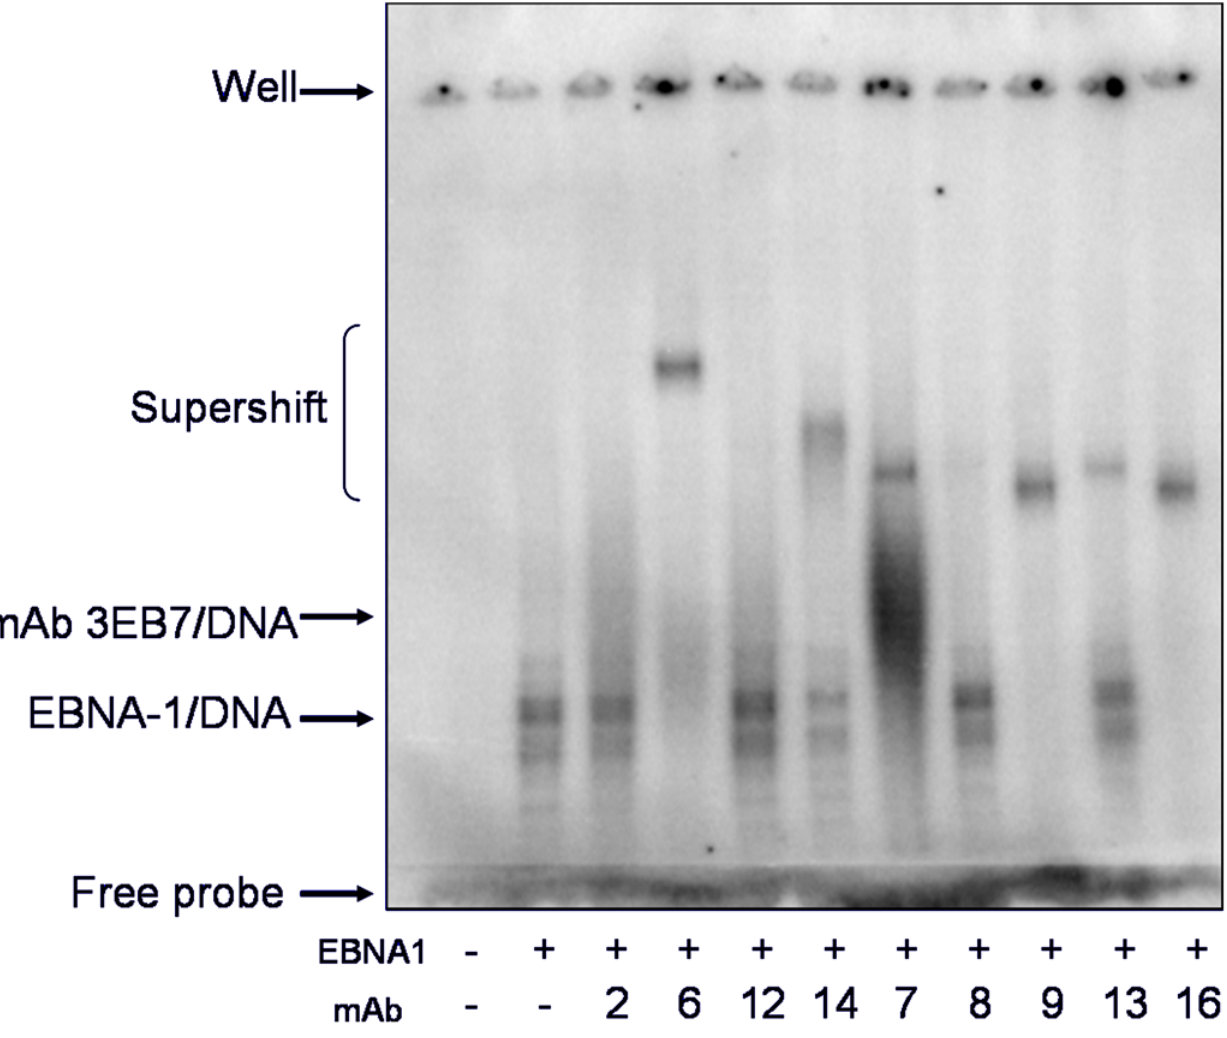
Figure 2. Ability of mAbs to bind EBNA1/DNA complex. MAbs were tested by EMSA to determine binding efficiency to a pre-formed EBNA1/ DNA complex. Purified EBNA1 protein was bound to a 32 P-labelled oligonucleotide encoding one palindromic EBNA1 binding site. Equal concentrations of purified mAb were added to each reaction and allowed to incubate. The ability of the mAbs to shift the EBNA1/DNA complex was analyzed by gel electrophoresis. The first lane does not include any protein. The second lane contains only DNA and EBNA1. MAbs are listed by the last number in their name.